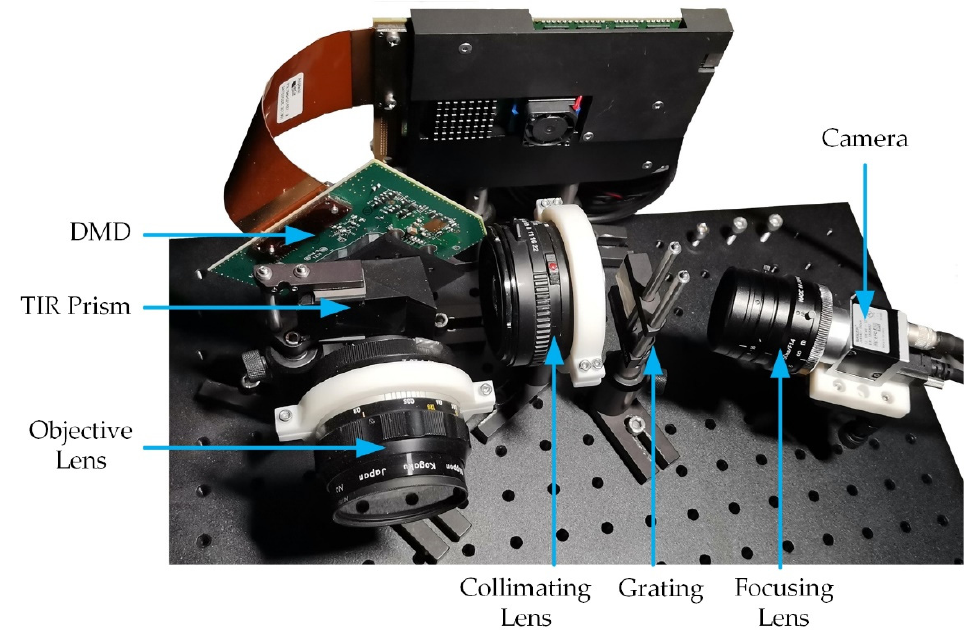
Figure 6. Implementation of single-path snapshot Hadamard transform spectrometer.